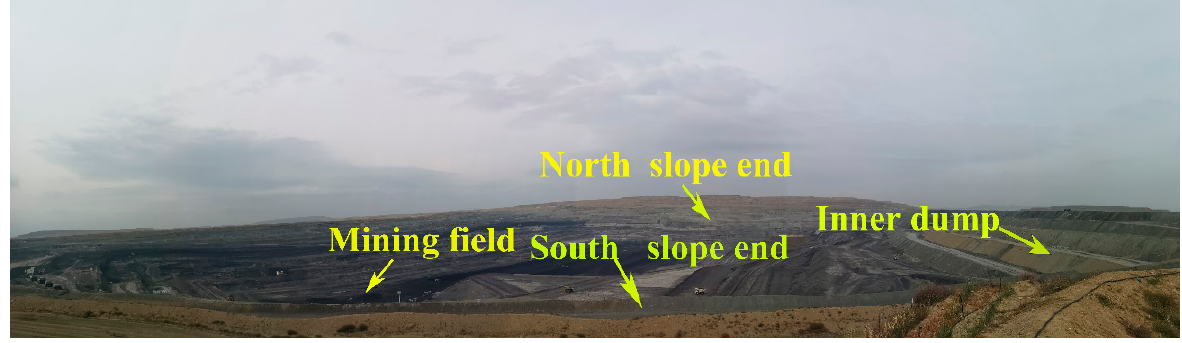
Figure 2. High slopes of Shengli #1 open-pit mine.